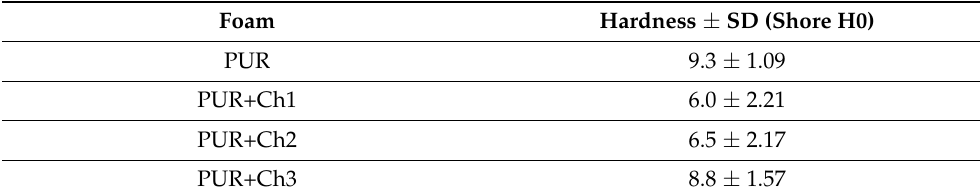
Table 3. Hardness (with standard deviation SD) of PUR and PUR+Ch